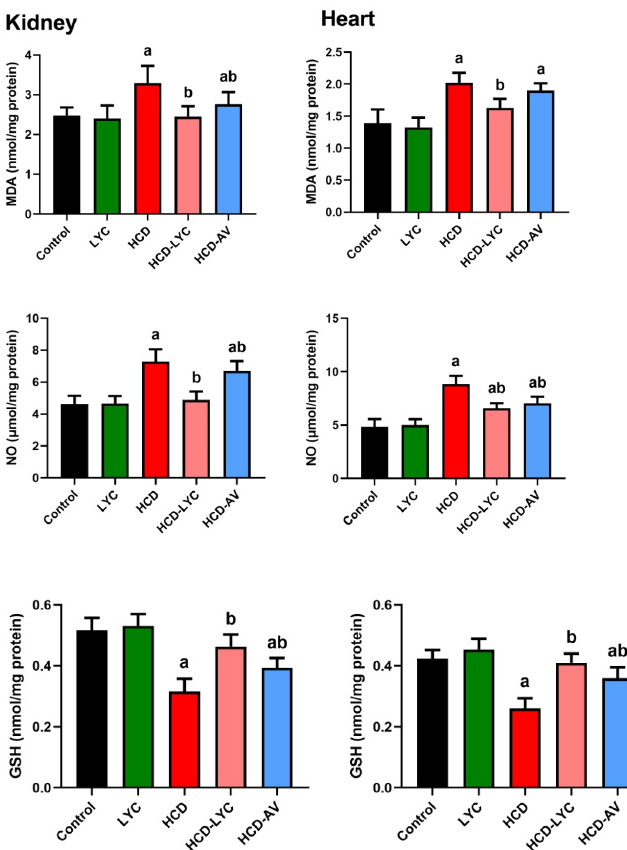
Figure 3. Effects of dietary cholesterol and lycopene on cardiac and renal malondialdehyde (MDA), nitric oxide (NO), and glutathione (GSH) levels in rat over 12 weeks. Letters a and b indicate statistically significant differences between control and HCD groups, respectively, at p < 0.05.